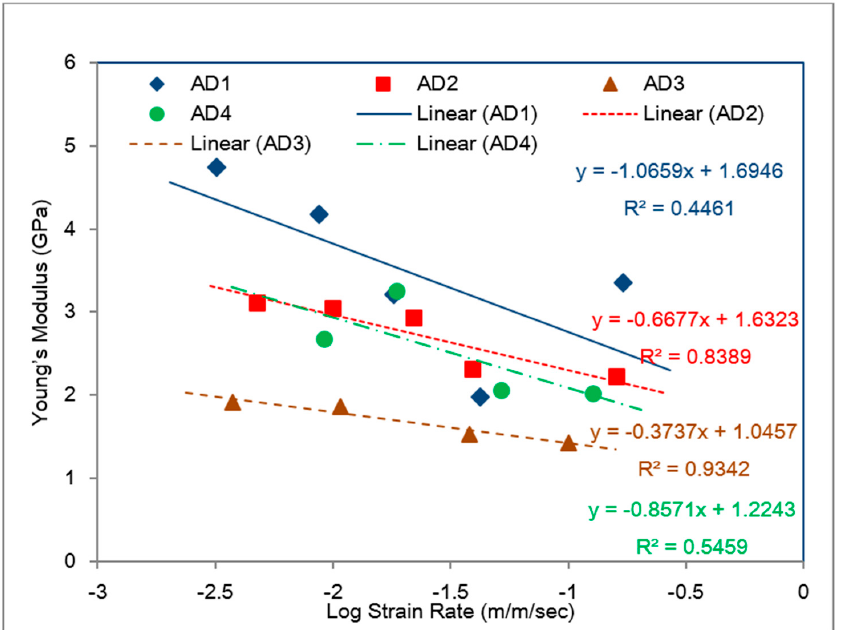
Figure 15. Variation of the elastic modulus E 2 (see Figure 14) as a function of strain rate during tensile tests.